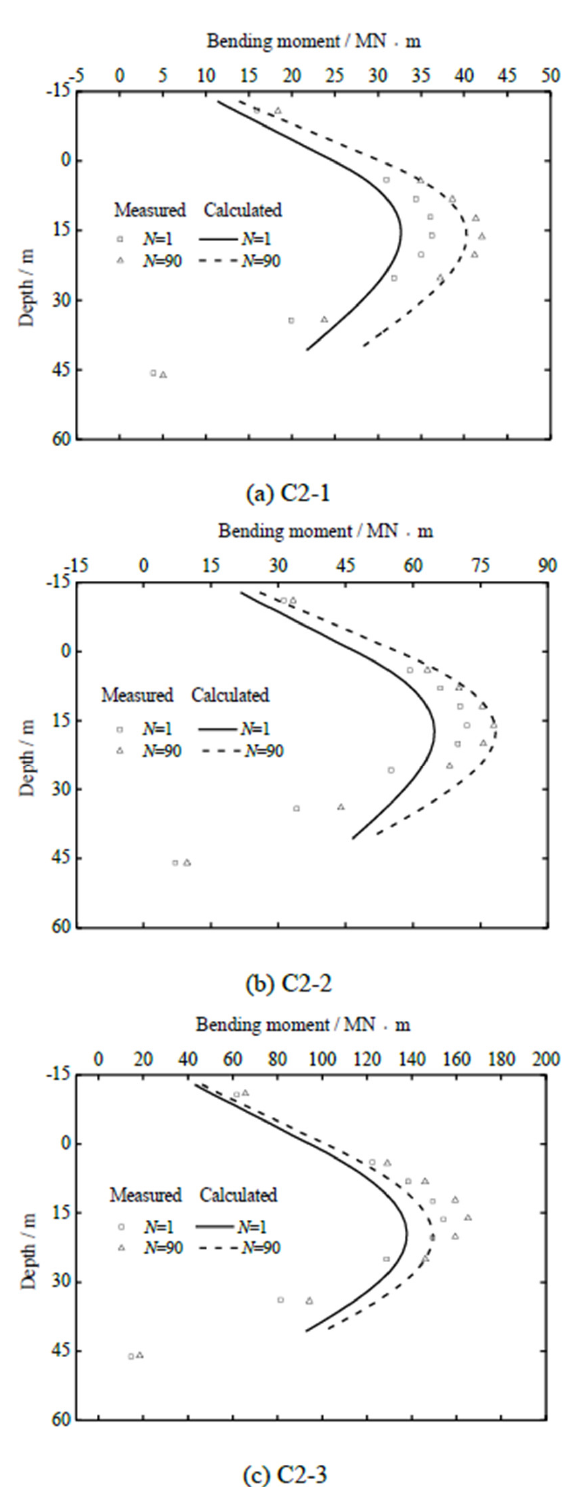
Figure 12. Comparison of cyclic bending moment.